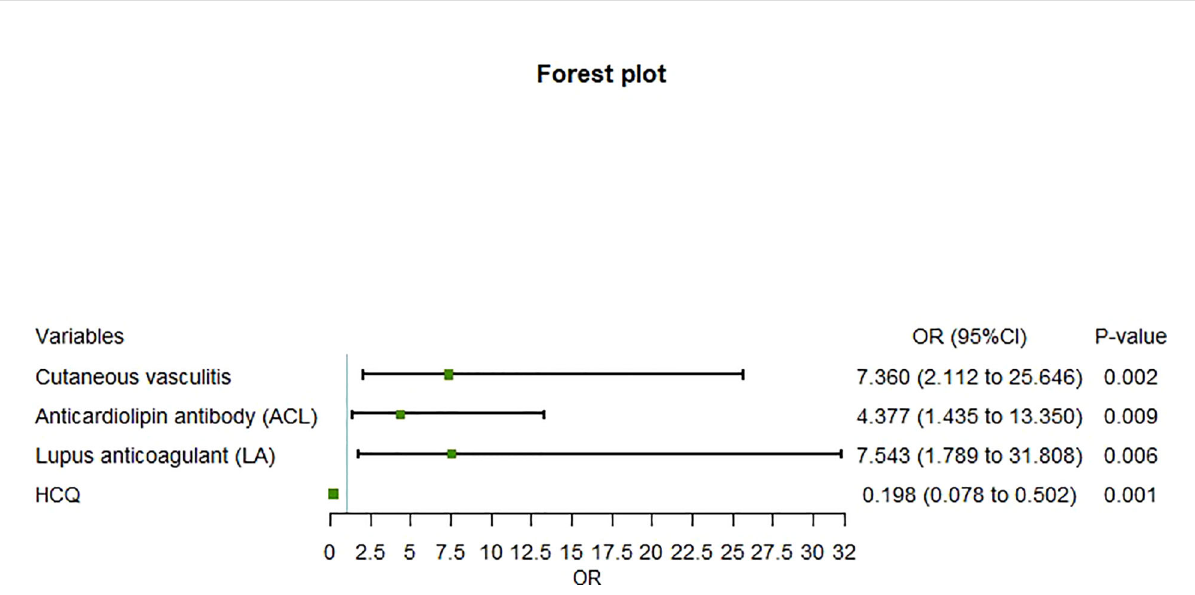
FIGURE 1 Forest plot of multivariate regression analysis of risk factors for ischemic cerebrovascular disease in patients with systemic lupus